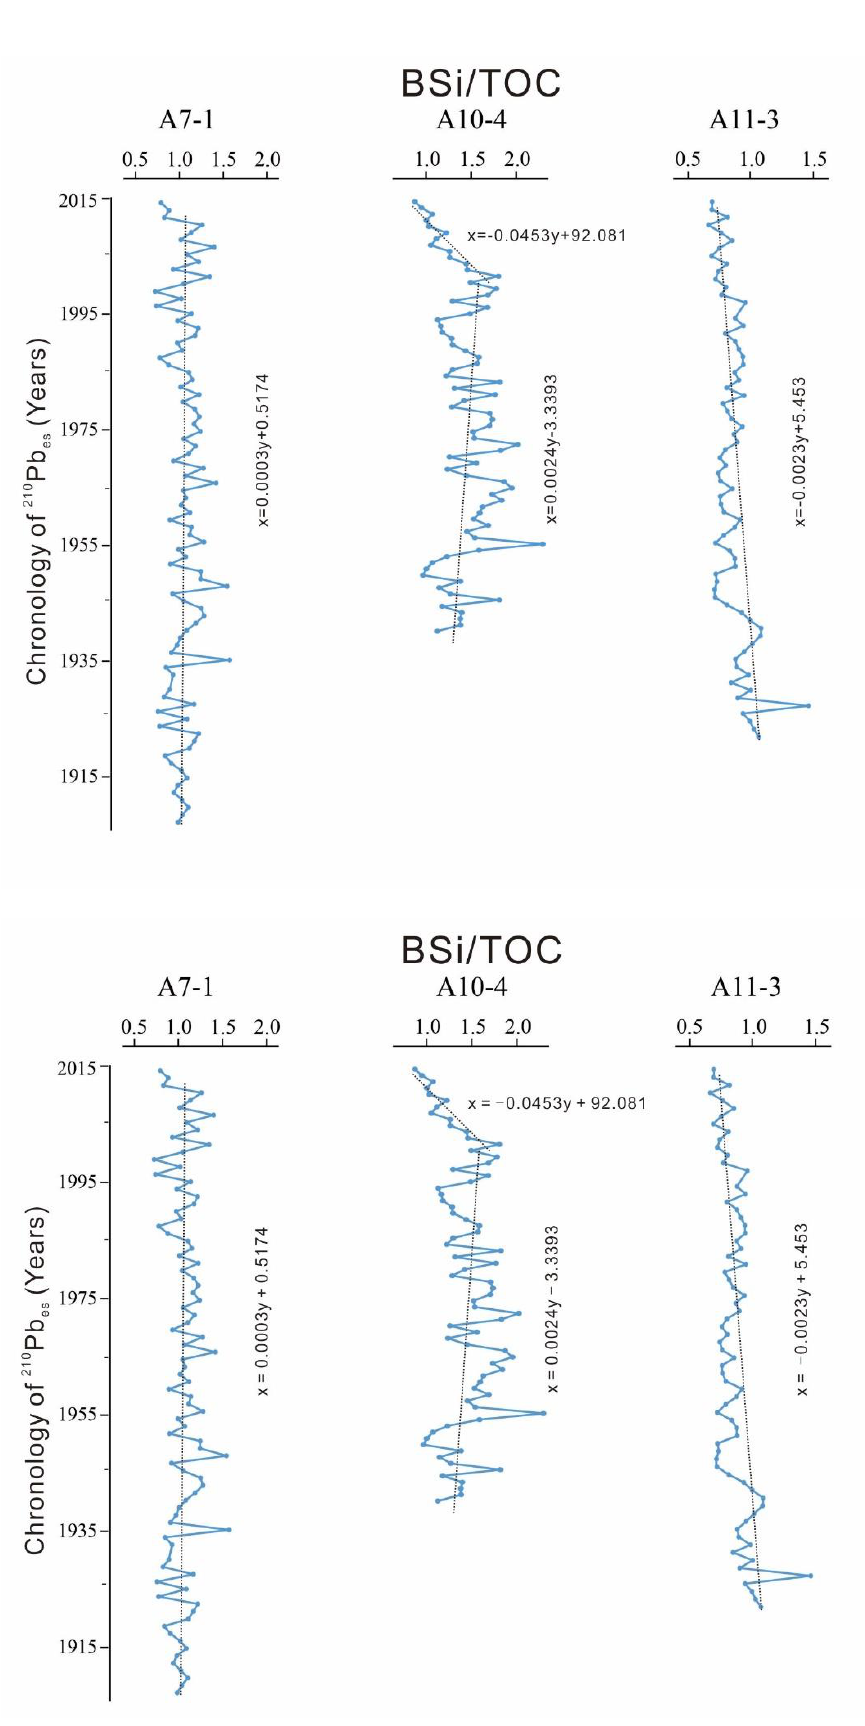
Figure 6. The variation of ratio of BSi/TOC.